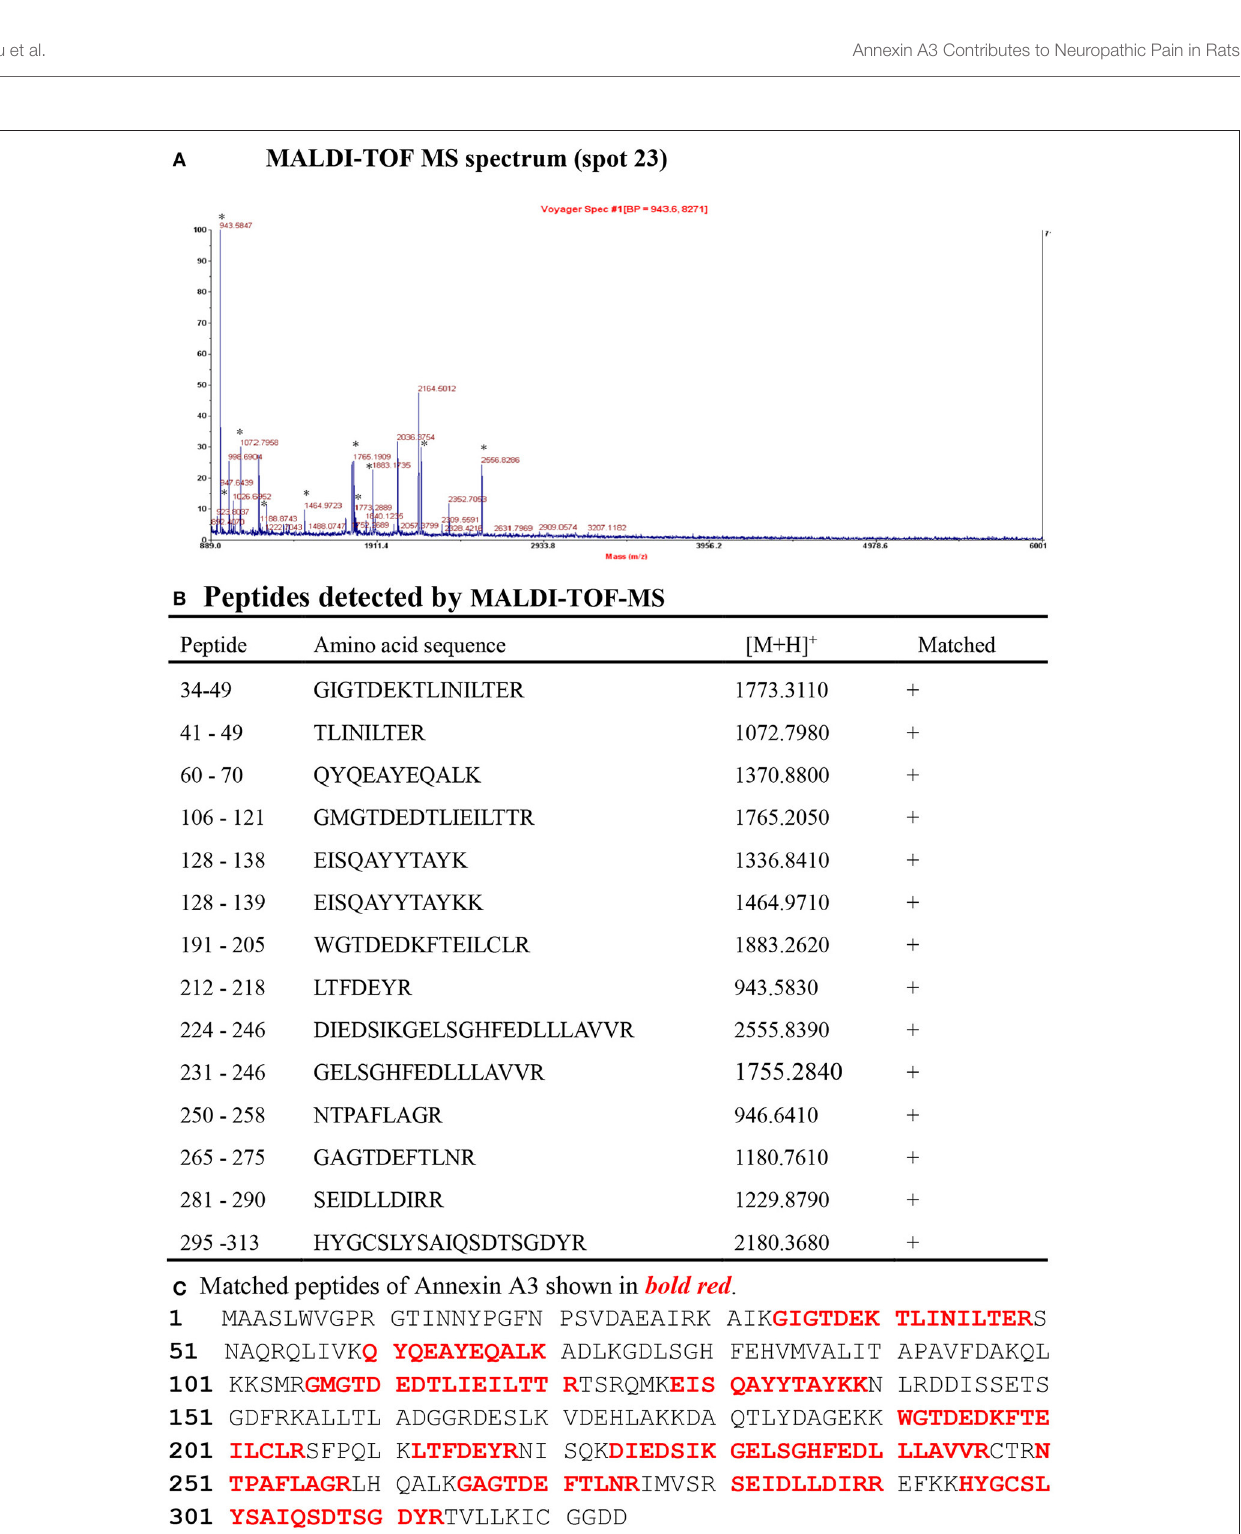
× (I.U.) 2 ]. Every spot-volume in a gel was normalized using the total spot-volume of the gel. The normalized spot-volume was implemented to identify every DEP with a difference ≥ two-fold